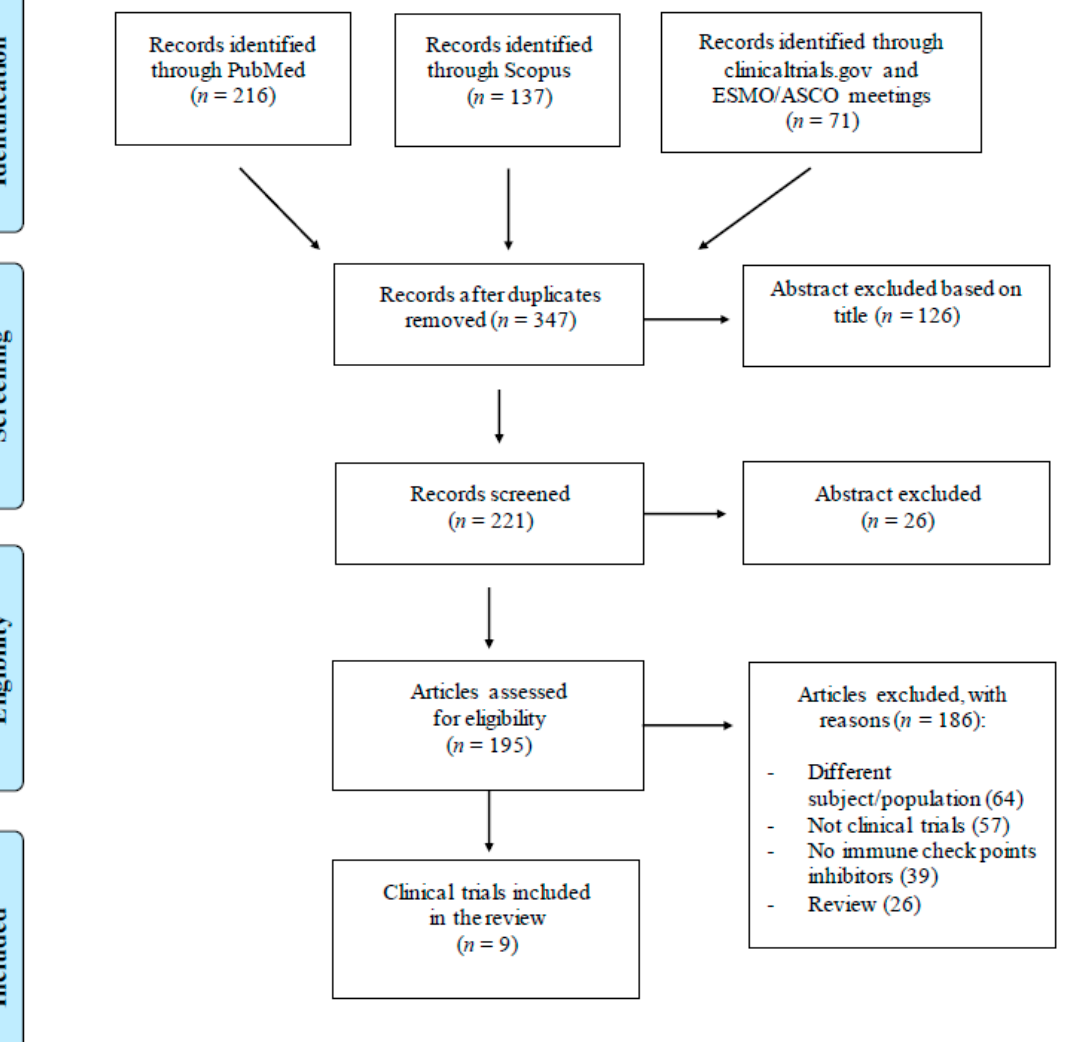
Figure 1. PRISMA flow diagram describing the data collection process following the PRISMA convention.